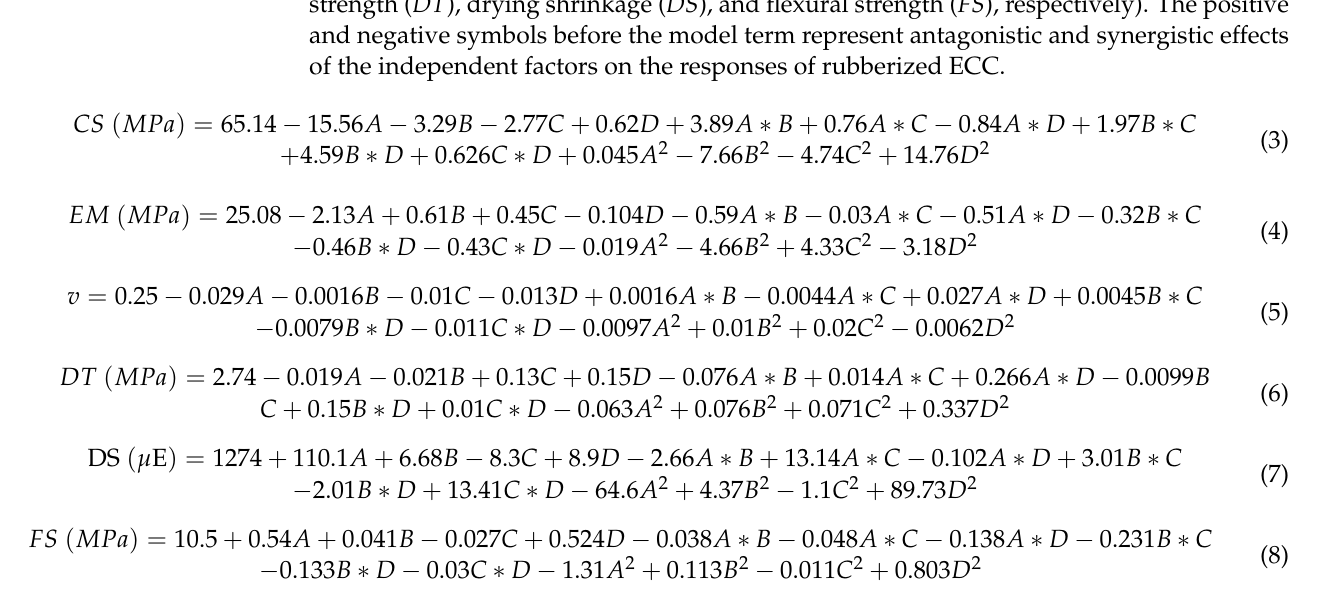
(for compressive strength ( CS ), elastic modulus ( EM ), Poisson’s ratio ( v ), direct tensile strength ( DT ), drying shrinkage ( DS ), and flexural strength ( FS ), respectively). The positive and negative symbols before the model term represent antagonistic and synergistic effects of the independent factors on the responses of rubberized ECC.